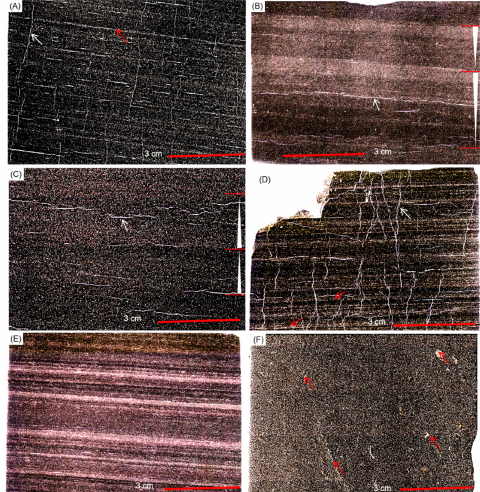
Figure 8. Large thin section images taken under orthogonal polarized light showing typical char- acteristics and fractures of the various depositional structures. Samples were collected from the Wufeng–Longmaxi shale of the Shuanghe outcrop in the Sichuan Basin of southwestern China. ( A ) PL, in which the silty laminae are linear, diffuse, discontinuous, or lenticular shaped and have sharp base and top contacts. Bedding parallel fractures commonly propagate from within clayey laminae (sample number 8-31); ( B ) GL-C, which consists of a series of bed IGB-C and has continuous, planar, and parallel bed boundaries. Bedding parallel fractures commonly propagate from along clayey–silty laminae interfaces (sample number 4-2-1); ( C ) GL-C, which consists of a series of bed NGB-C and has continuous, planar, and parallel bed boundaries. Bedding parallel fractures com- monly propagate from within clayey laminae (sample number 5-29); ( D ) GL-SC, with continuous, planar, and parallel bed boundary. Bedding parallel fractures commonly propagate from within clayey laminae (sample number 9-15-1); ( E ) IL, with continuous, planar, and parallel geometry and sharp contact boundaries, is composed of the interbedded silty laminae and clayey laminasets (sample number 9-5-1); and ( F ) SB, which contains numerous bioclasts of various species (sample number